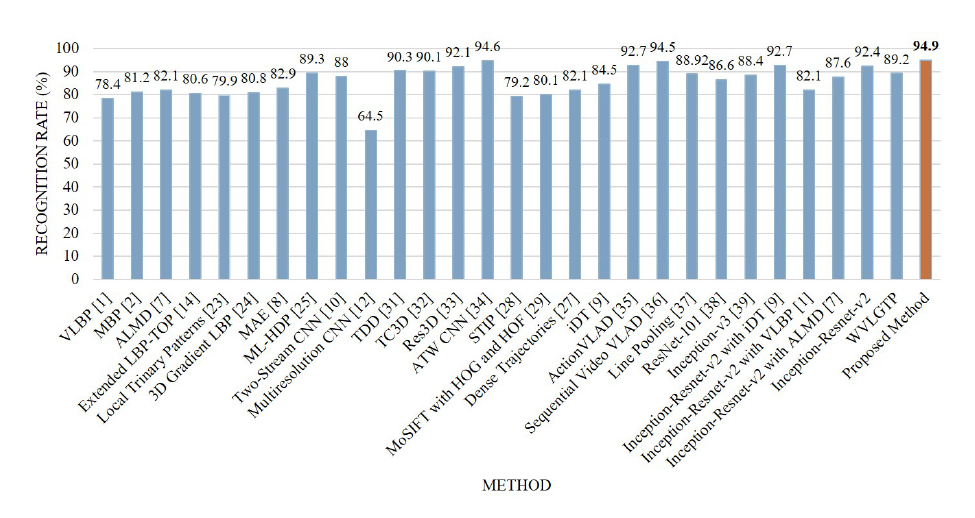
Figure 16. Comparison between the proposed method and other state-of-the-art approaches on the UCF101